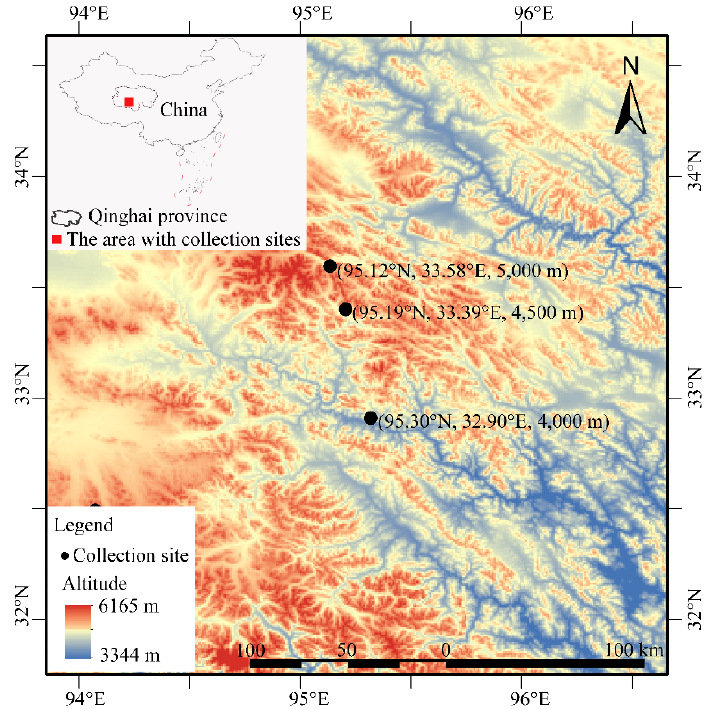
Figure 1. The collection sites of the two studied bumblebee